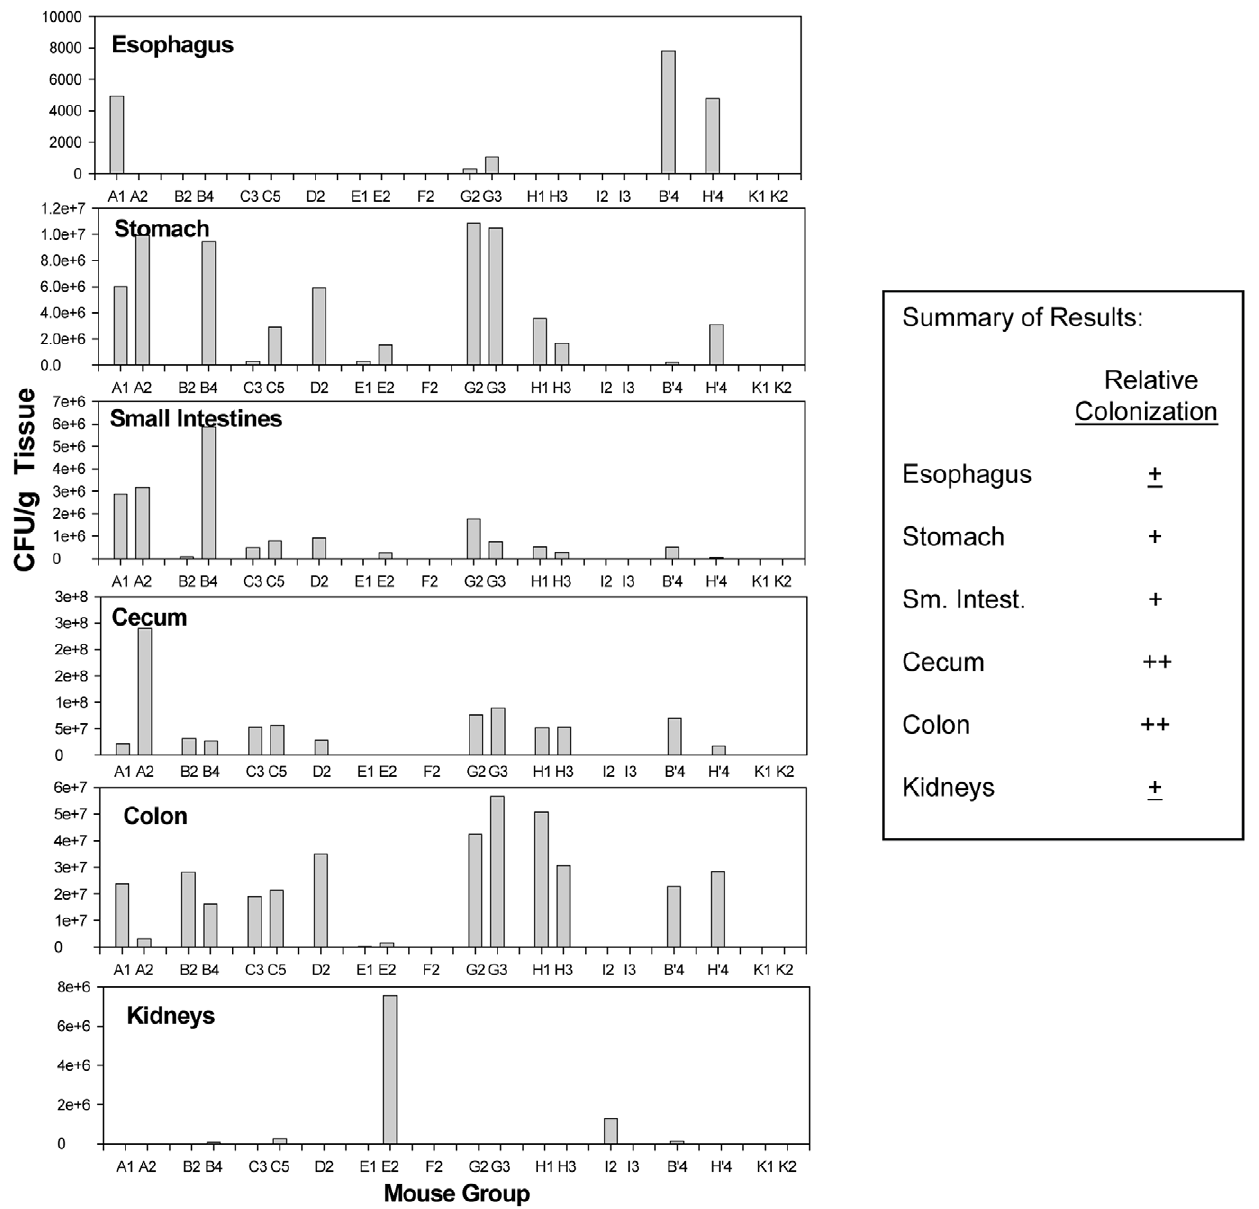
Figure 4. GI-tract colonization was especially profound in the cecum and large intestine. Mice that survived the experiment (Fig. 3), were sacrificed by CO 2 asphyxiation, the GI-tract was sectioned into major components, homogenized and plated for fungal burden ( C. albicans CFU/gram tissue). Each mouse per group that survived for processing are noted on the X-axis.